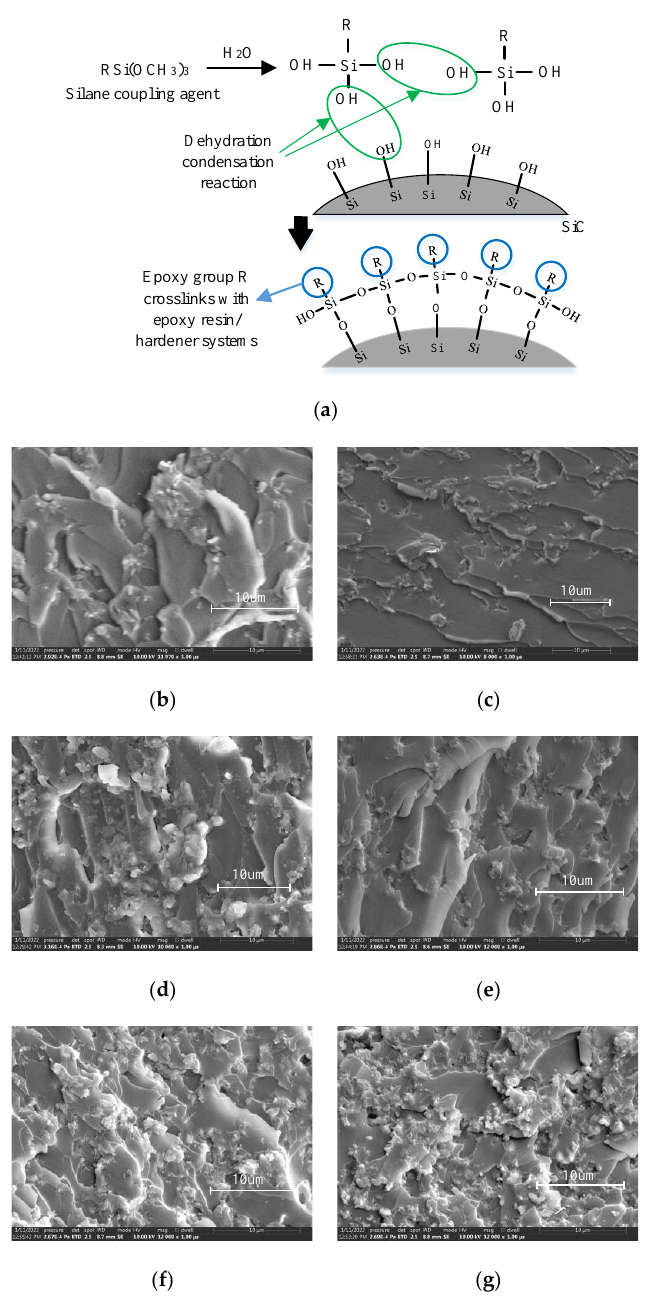
Figure 8. ( a ) Modification of SiC surface by silane coupling agent KH560; ( b – g ) Cross-sectional SEM image of SiC/EP composites; ( b ) 10 wt% surface modified SiC/EP; ( c ) 10 wt% surface unmodified SiC/EP; ( d ) 20 wt% surface modified SiC/EP; ( e ) 10 wt% surface unmodified SiC/EP; ( f ) 30 wt% surface modified SiC/EP; ( g ) 30 wt% surface unmodified